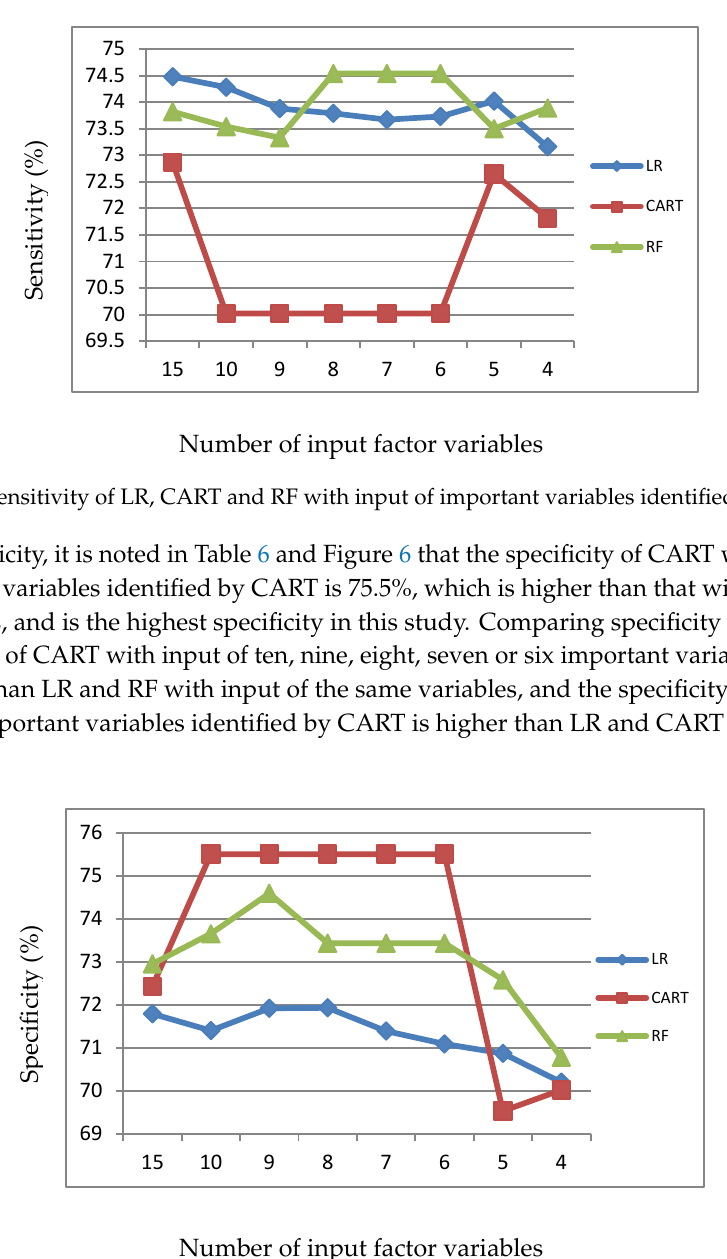
Figure 6. Specificity of LR, CART and RF with input of important variables identified by CART.